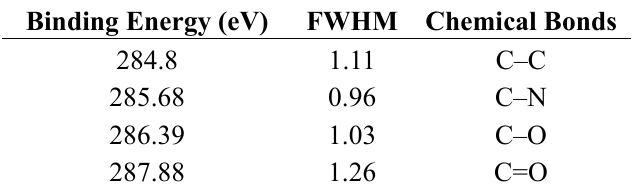
Figure 18. The chemical equations between TGMPP and PA66. Table 1. The binding energy, FWHM and chemical bonds corresponding to the C1s peak value of TGMPP.